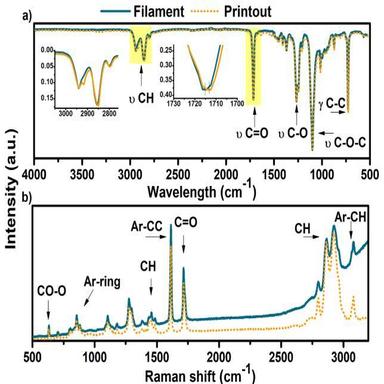
FTIR (a) and Raman (b) spectra of Bioflex® filament and selected printout.